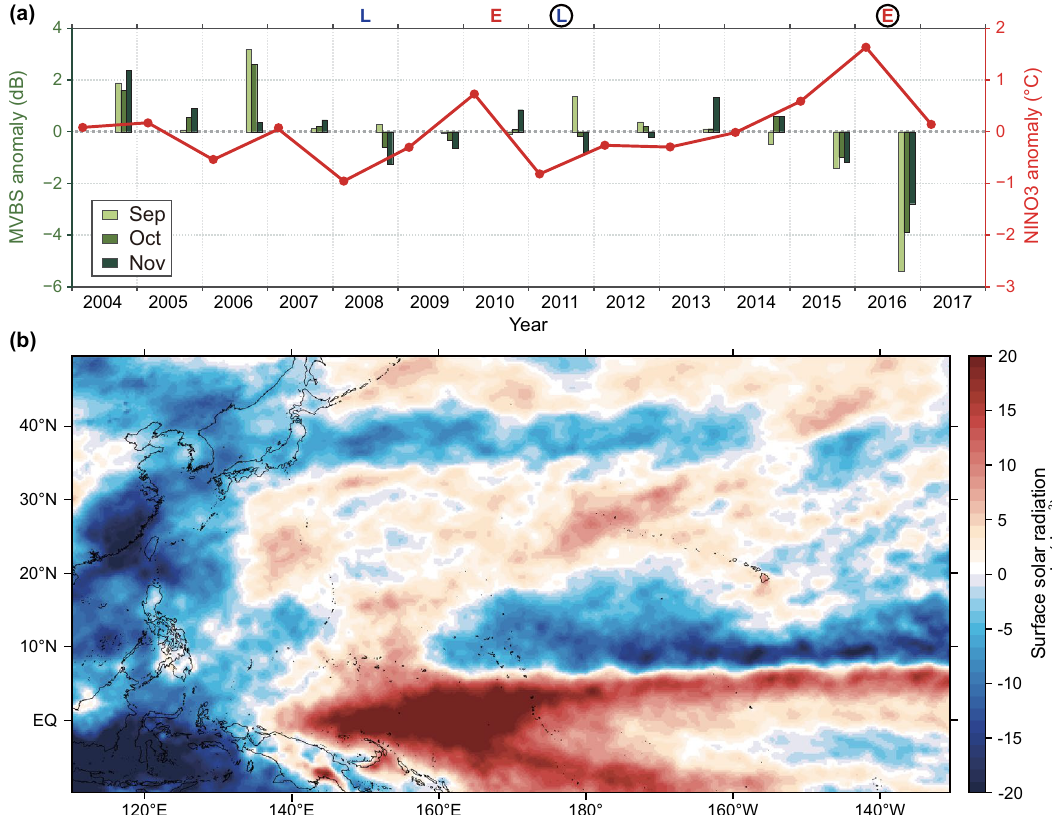
Figure 3. | Remote impact of winter (DJF) and spring (MAM) NINO3 on the fall (SON) mean volume backscattering strength (MVBS) through external climatic factors. ( a ) Fall MVBS anomaly (green bars) and averaged NINO3 anomaly (red line) for winter and spring. E and L on top of ( a ) indicate the decaying years of El Niño and La Niña events, respectively. Surrounding black circles mean that NINO3 and PDO are in phase and maintain their signs from winter to fall. ( b ) Composite maps of the averaged anomalies of surface solar radiation during the decaying fall of El Niño years (2009/10 and 2015/16). The figure was created using MATLAB (ver. 9.9.0.1592791 (R2020b) Update 5). The coastline is based on the ETOPO1 dataset (https:// www. ngdc. noaa.